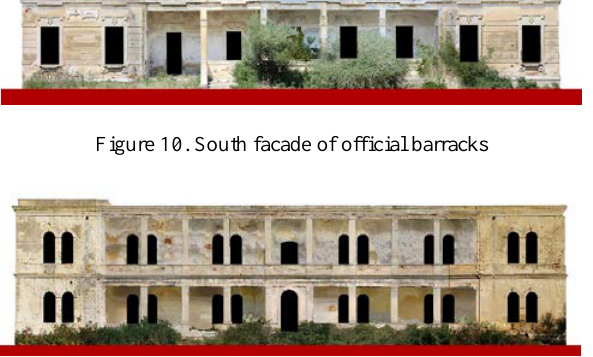
Figure 11. South facade of the dormitory for soldiers